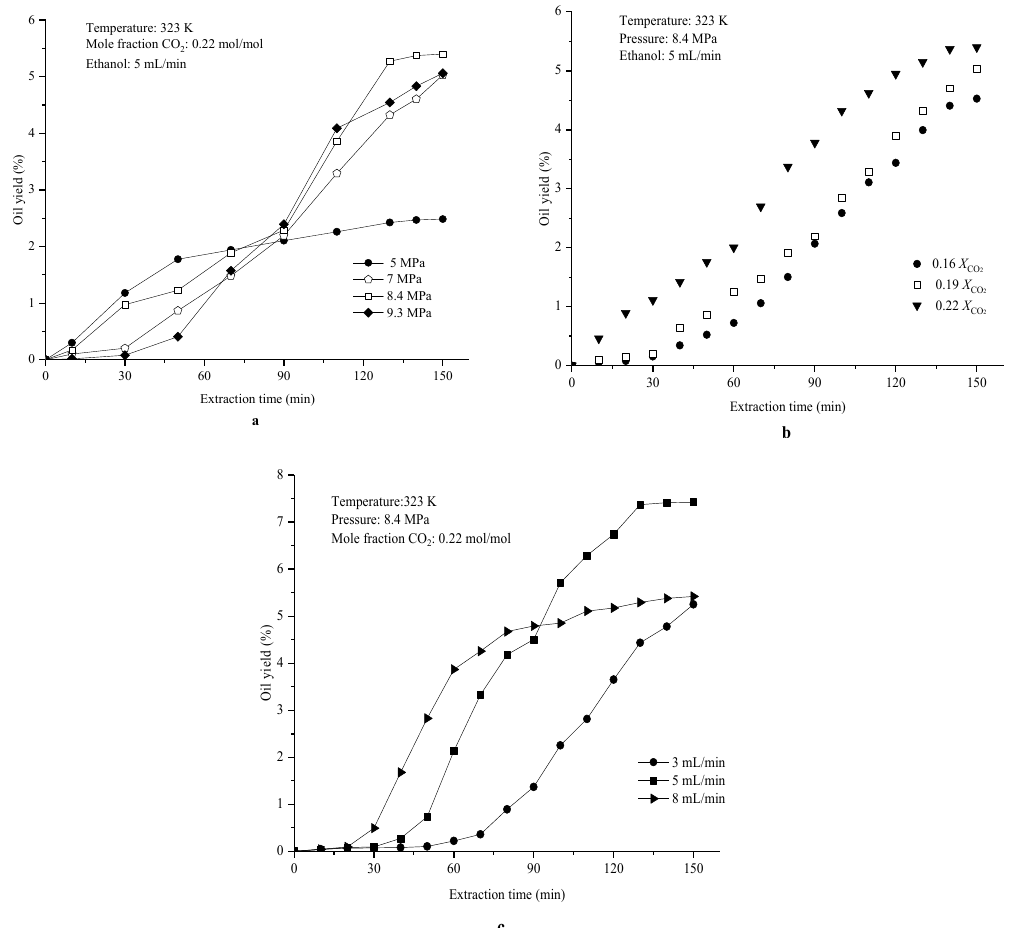
Figure 2. E ff ect of pressure, ethanol flow rate, and mole fraction of CO 2 on vetiver oil yield at a fixed temperature of 323 K. ( a ) E ff ect of pressure on vetiver oil yield at a constant CO 2 mole fraction of 0.22 and an ethanol flow rate of 5 mL / min. ( b ) E ff ect of CO 2 mole fraction on vetiver oil yield at a constant pressure of 8.4 MPa and an ethanol flow rate of 5 mL / min. ( c ) E ff ect of the ethanol flow rate on vetiver oil yield at a constant pressure of 8.4 MPa and a CO 2 mole fraction of 0.22.